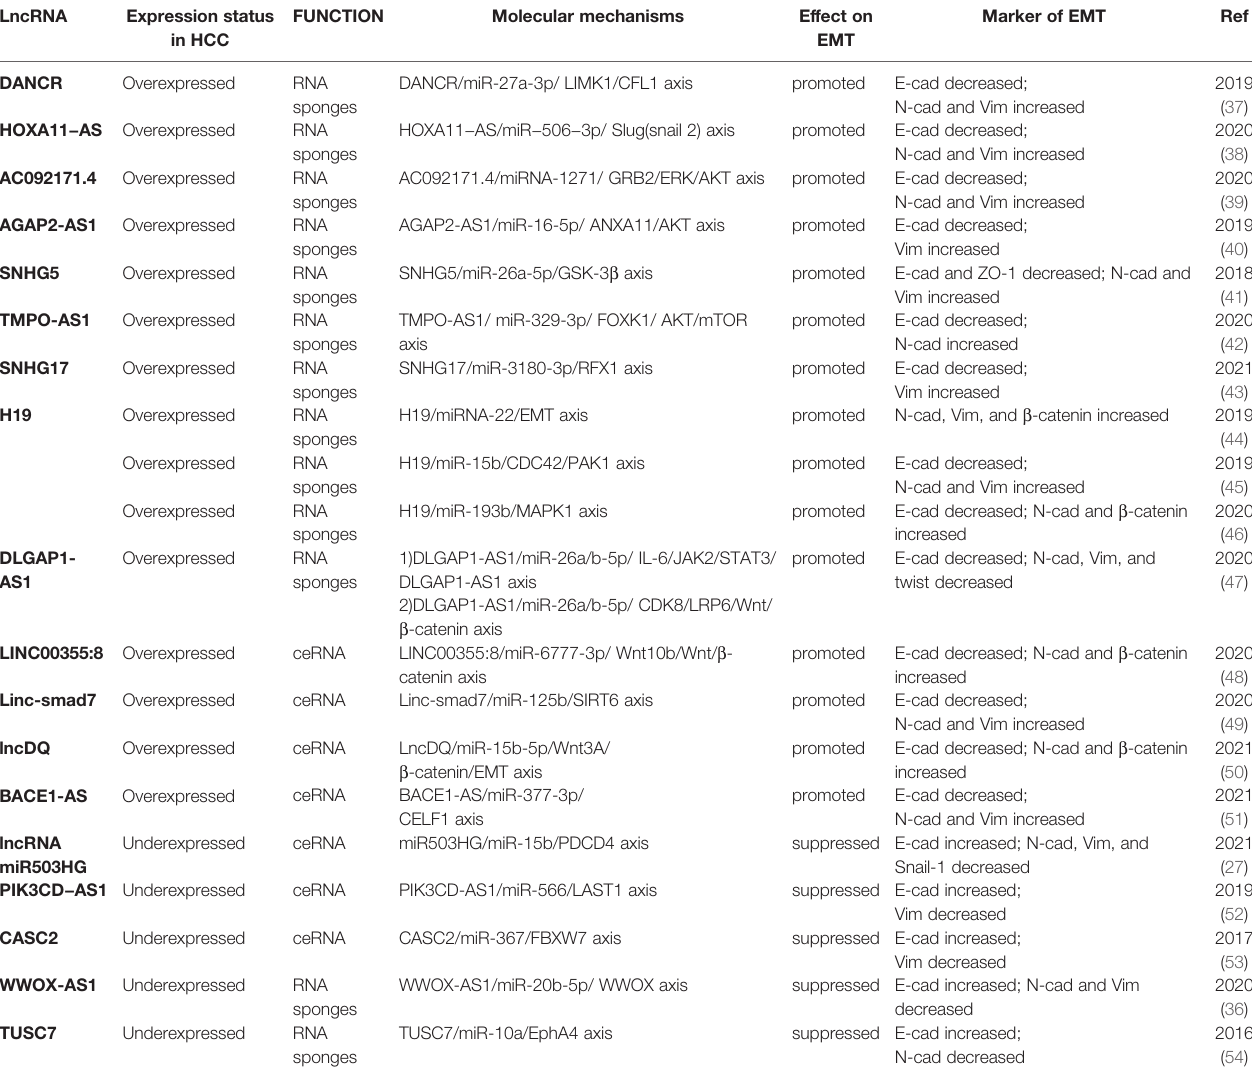
TABLE 1 | LncRNAs that act as RNA sponges or ceRNAs to regulate